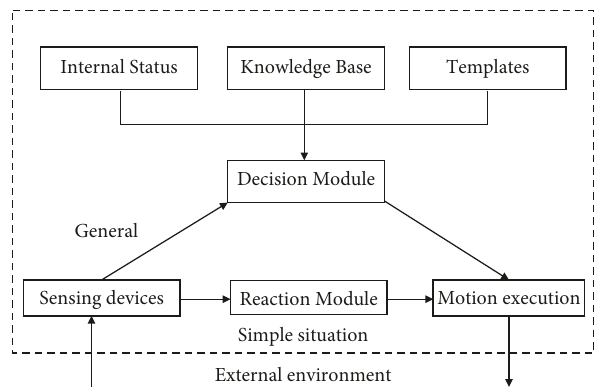
Figure 5: Hybrid smart body